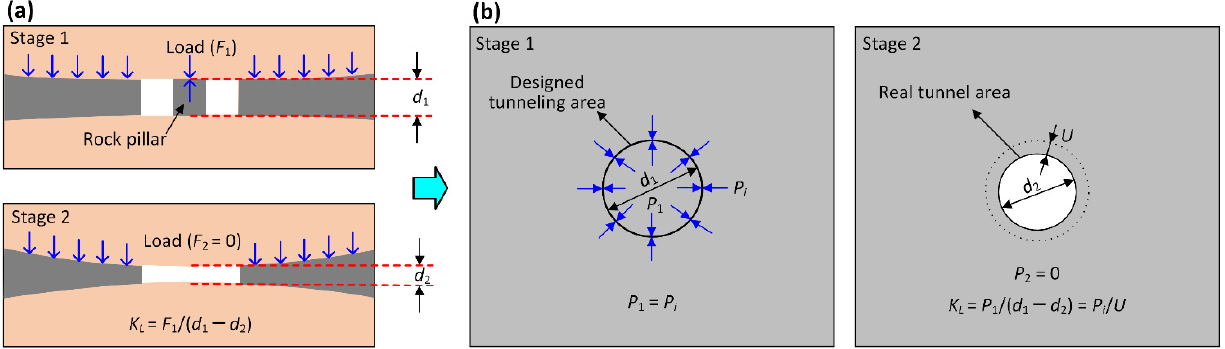
Figure 5. Determination of local mine stiffness by numerical modeling. ( a ) Local mine stiffness calculation for a rock pillar (after Jaiswal and Shrivastva [47]). ( b ) Proposed calculation method of local mine stiffness for a tunnel.